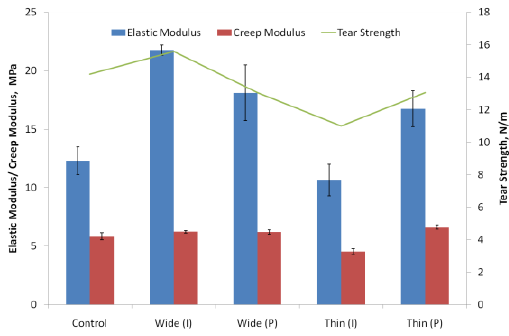
FIGURE 1: The tensile properties of Carbothane ® with 1% impure (I) and pure (P) carbon